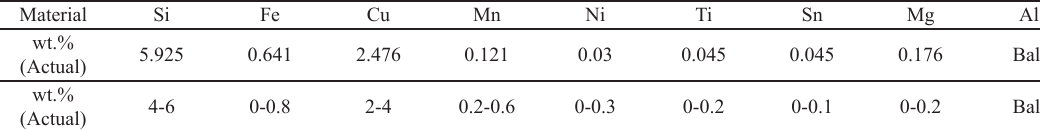
Table 2. Chemical composition of LM4 alloy.